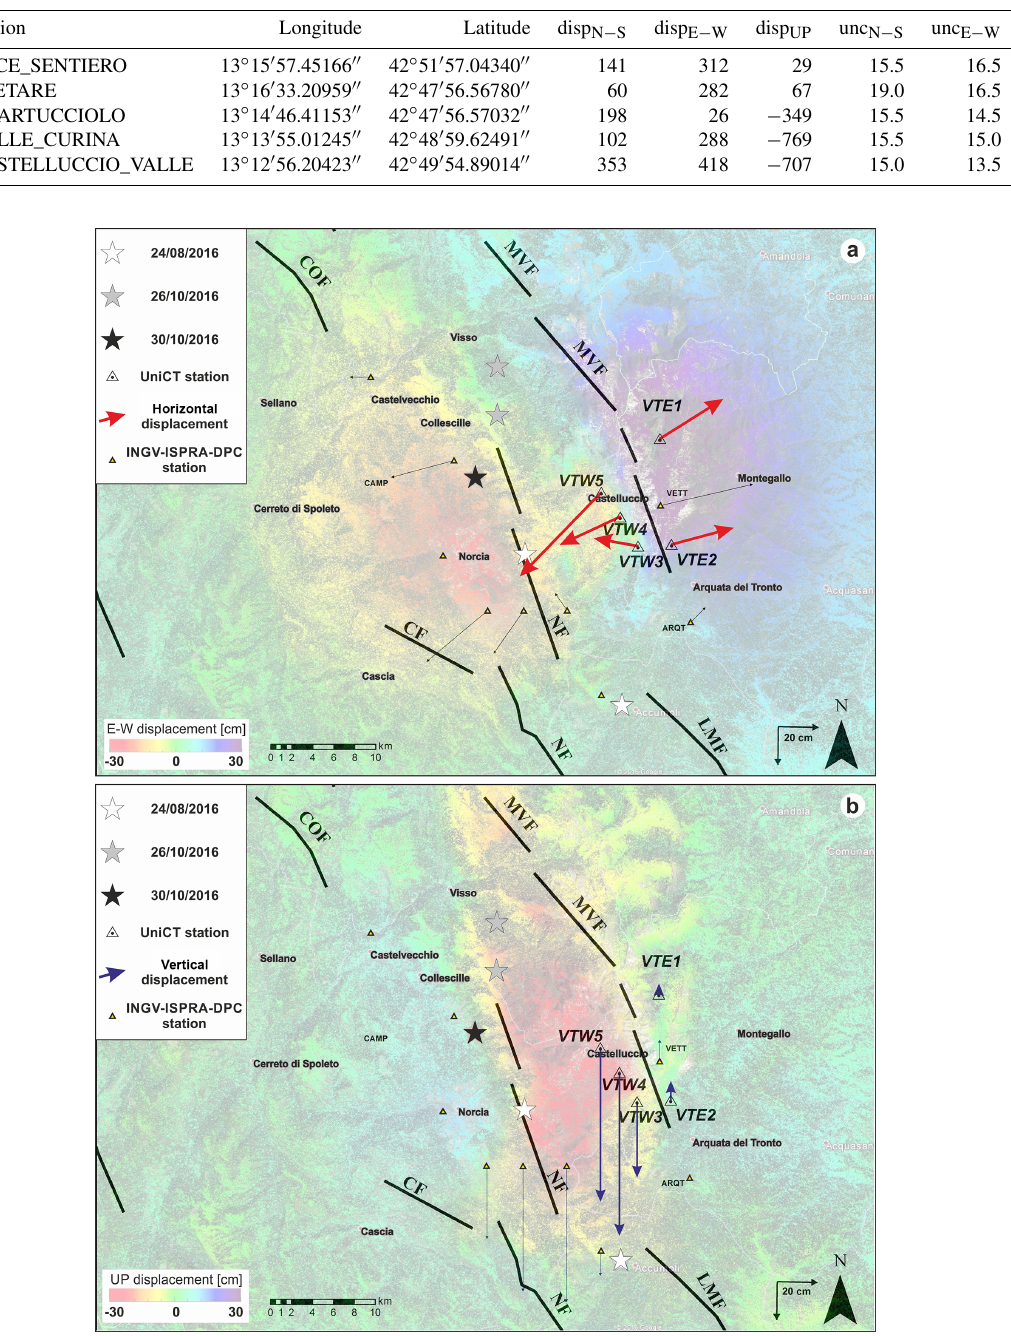
Figure 5. Colour-coded maps showing the E–W (a) and vertical (b) displacement distribution obtained by the DInSAR technique (http://www.irea.cnr.it/index.php?option=com) recorded on 26 October 2016 (pre-event images) and on 1 November 2016 (post-event im- ages). The red and blue arrows represent the consensus pre-, co-, and post-seismic displacements (with 95% confidence errors) on the basis of the GNSS UNICT network. Epicentres of major shocks are from